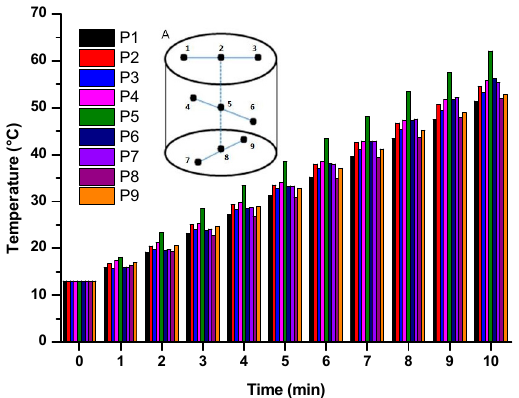
Figure 1. The temperature variation of each point (P1–P9) under microwave heating at 100 W for 10 min. A: the point location in cylindrical resonant cavity.